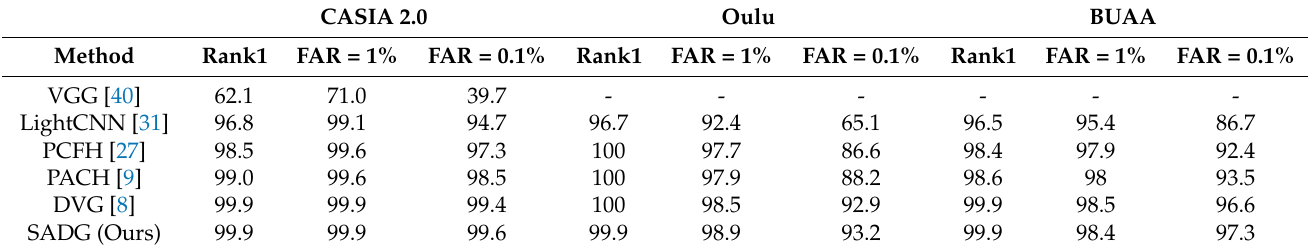
Table 2. Comparison of Rank1 accuracy (%) and verification rate (%) on the CASIA NIR-VIS 2.0, Oulu-CASIA NIR-VIS and BUAA VIS-NIR